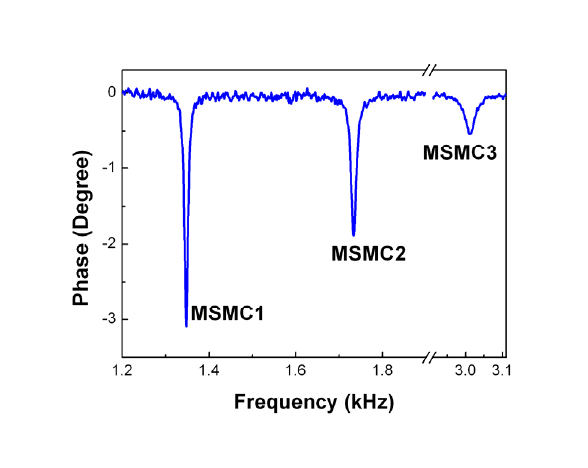
Figure 5. Spectrum of an MSMC array consisting of three